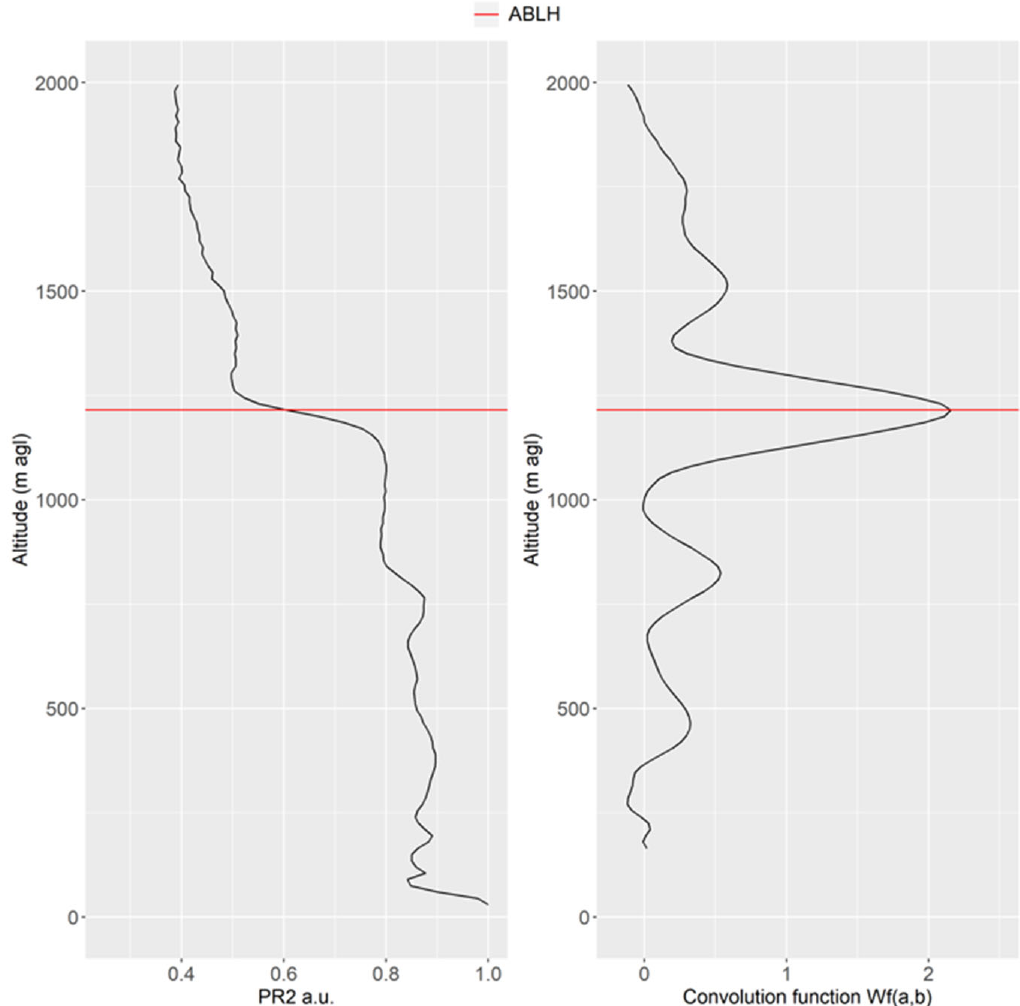
Figure 2. PR2 profile in arbitrary units ( left ) and convolution function W f ( a , b ) ( right ) 2021 06:50. The ABLH is indicated by the red horizontal line and calculated as the b for which the (cid:4666)𝑎 , 𝑏(cid:4667) function is the maximum.